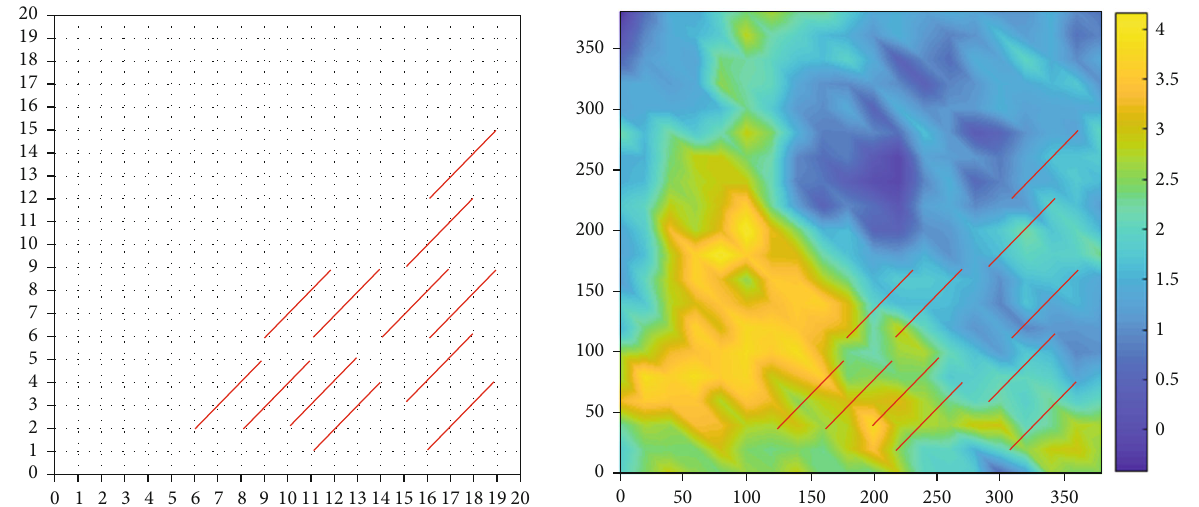
Figure 12: Log-permeability distribution example